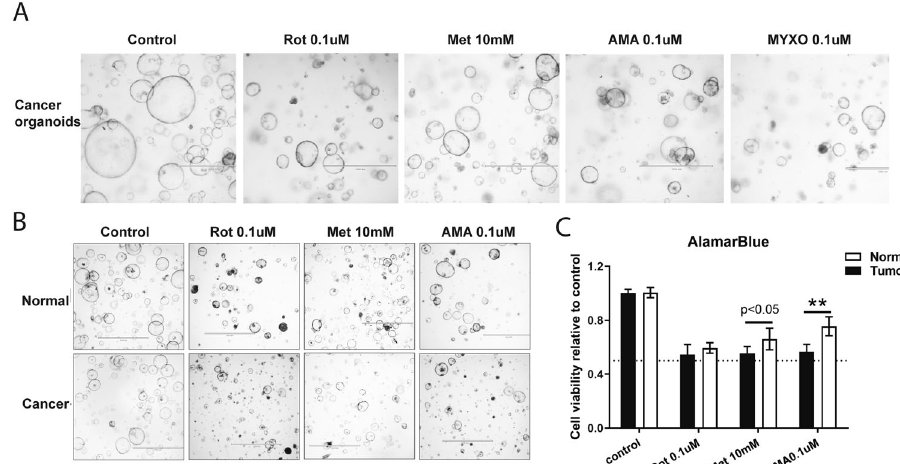
Fig. 2 mETC complex I and III inhibitors impaired the growth of mouse liver tumor organoids. A Optical microscope images of liver tumor organoids after treating with the mETC complex I inhibitors (Rotenone, ROT; Metformin, Met) and complex III inhibitors (Antimycin A, AMA; Myxothiazol, MYXO) for 48 h ( N = 3). B Optical microscope images of liver tumor organoids and normal liver organoids after treating with AMA, Met, and ROT for 48 h ( N = 9). C The growth rates of tumor and normal liver organoids were measured by Alamar Blue assays ( N = 9). Results are presented as mean ± SD, and group differences were tested by Mann – Whitney U